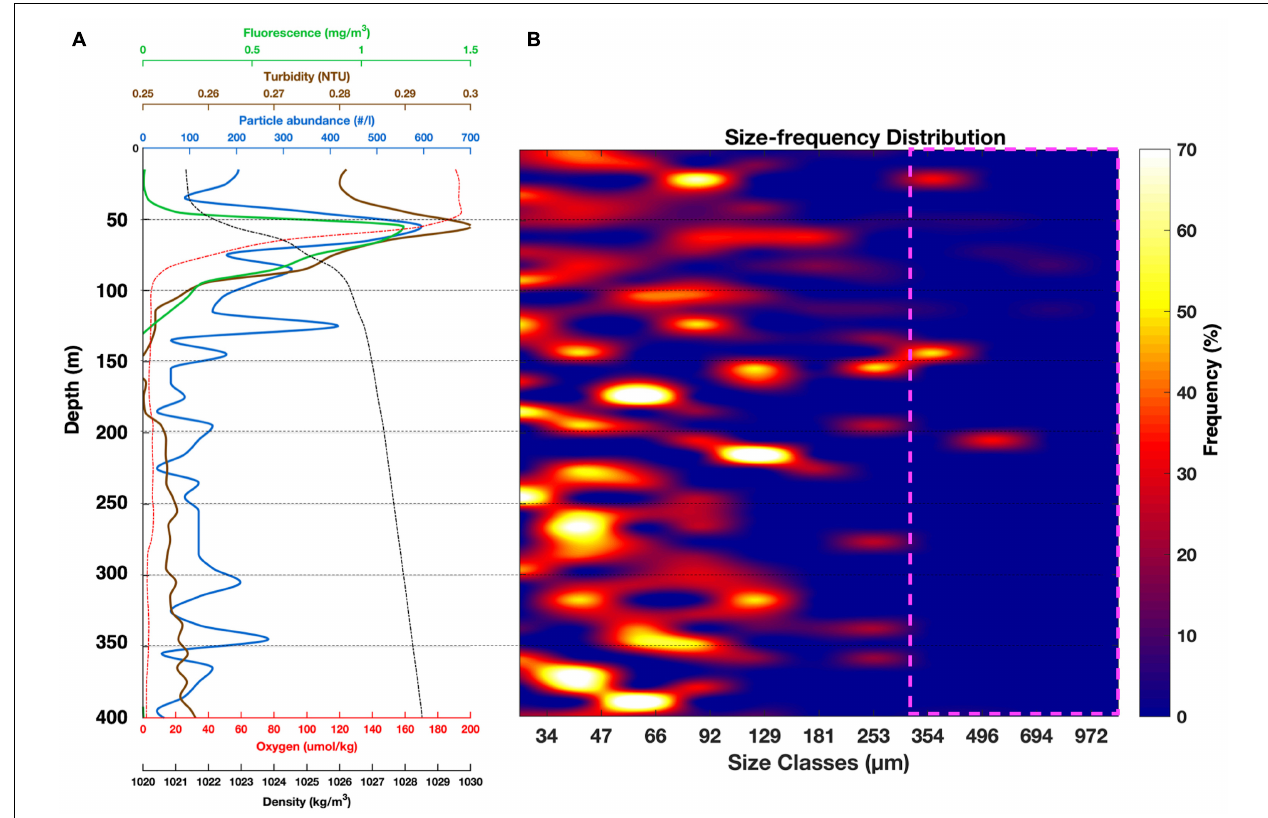
FIGURE 6 | Particle abundance, size distribution and oceanographic parameters from station 2.1. (A) Vertical cross section from CTD data (fluorescence, turbidity, oxygen, density) and particle abundance vs. depth. (B) Particle size-distribution expressed as percent frequency vs. depth. Pink square: statistically low particle count